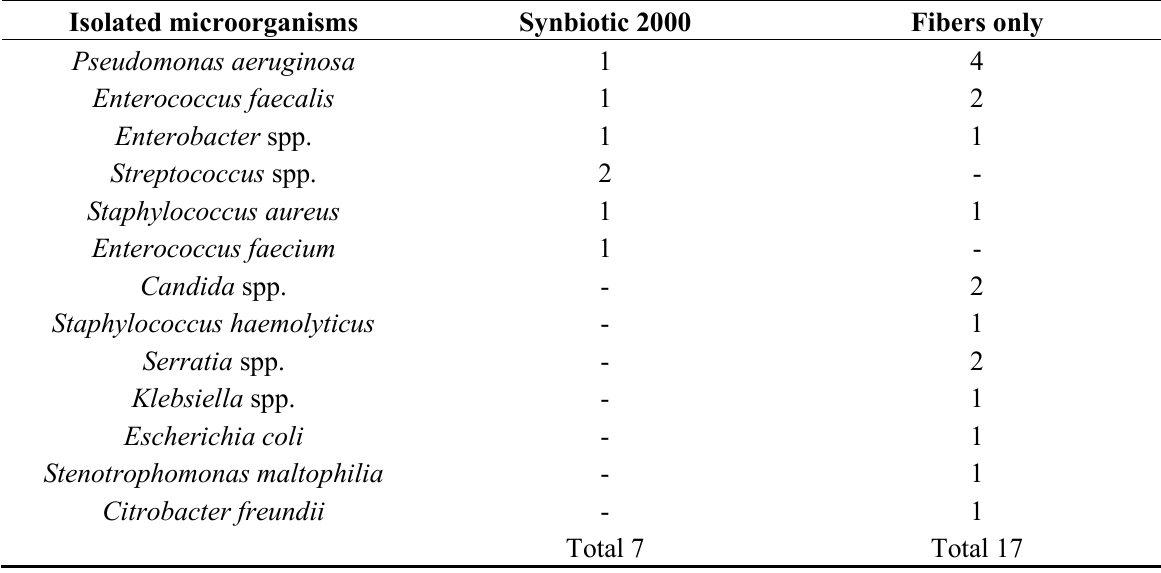
Table 11. Pathogens isolated from patients with acute pancreatitis treated with Synbiotic 2000 versus those receiving only fibers